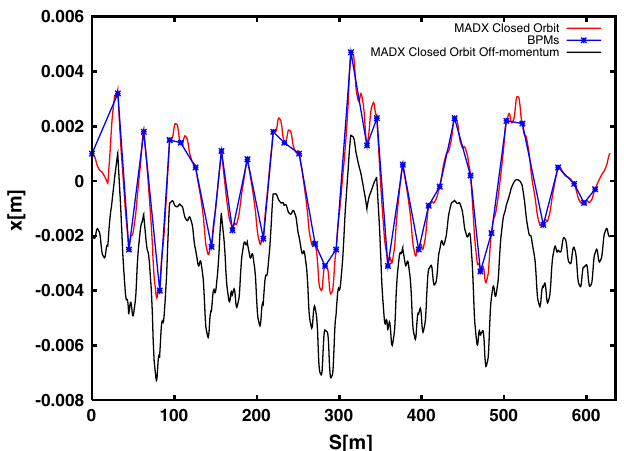
FIG. 9. PS closed orbit simulated and measured before the pulsing of the slow